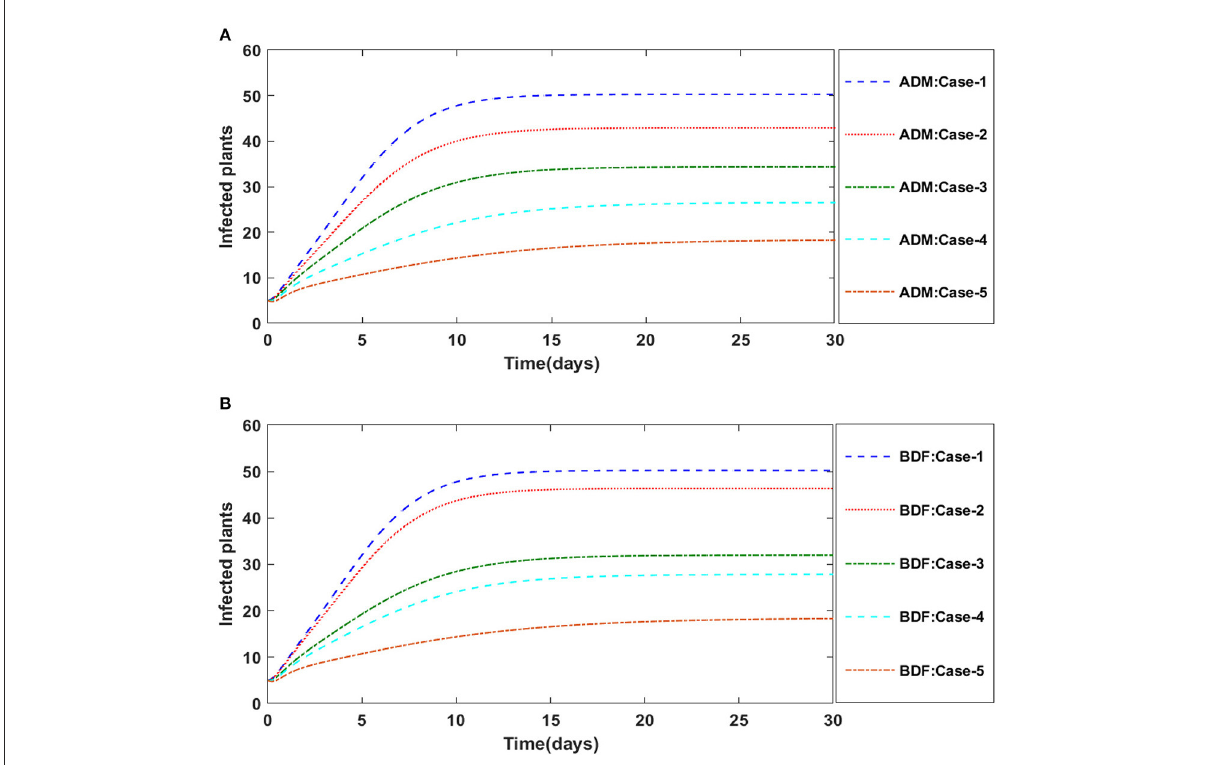
FIGURE15 (A) Dynamics of infected plants for the varition in d using ADM for model B. (B) Dynamics of infected plants for the varition in d using BDF for model B.